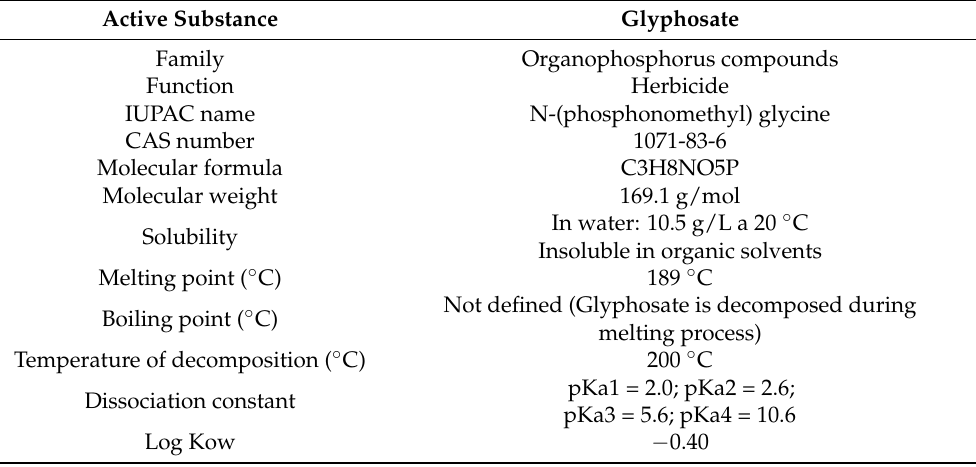
Table 1. Glyphosate’s physical and chemical